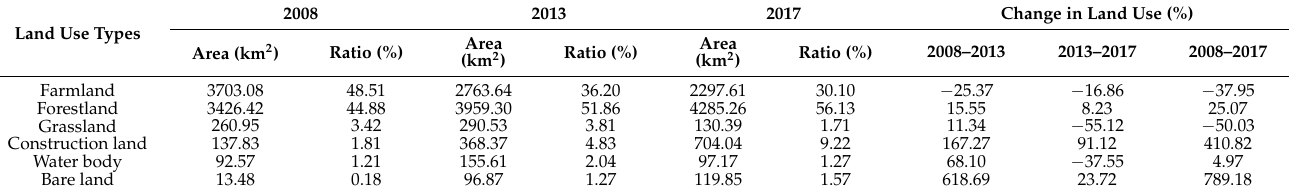
Table 3. The area and ratio of different land use types in 2008, 2013 and 2017.